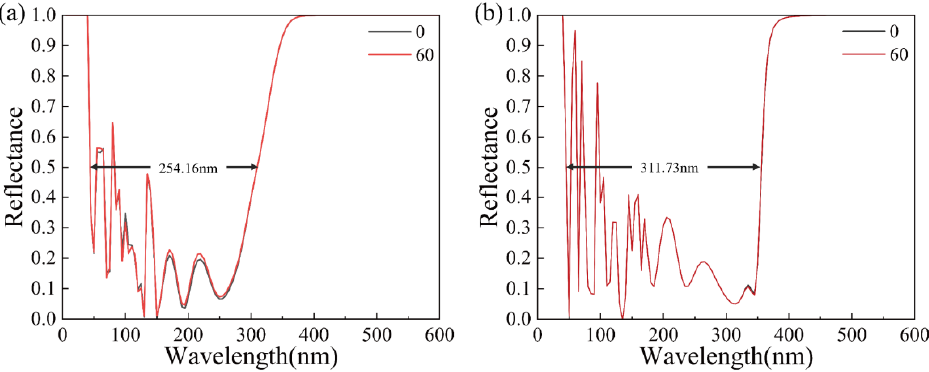
Figure 4. The reflectance curve of pure titanium dioxide (TiO 2 ) SPR sensors at different thicknesses of TiO 2 film: ( a ) 10 nm and ( b ) 160 nm.